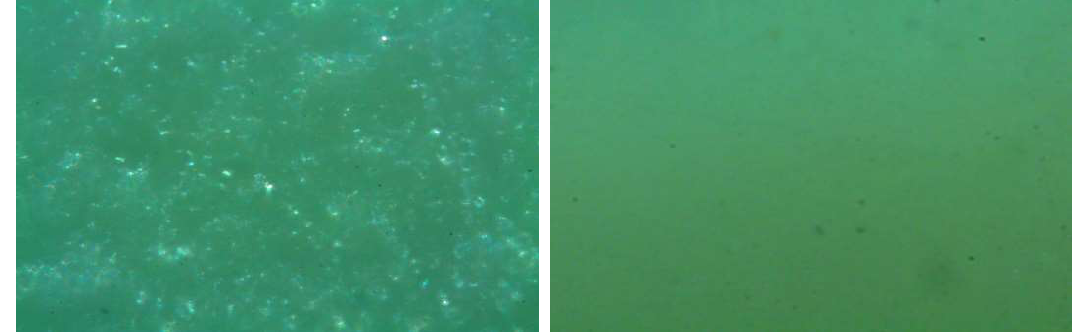
Figure 7. Microscope images (40×) with a polarized light filter of PVC blends containing 40 phr of 1,4-BDB ( left ) and DEHP ( right ), taken 48 h after test bar production.